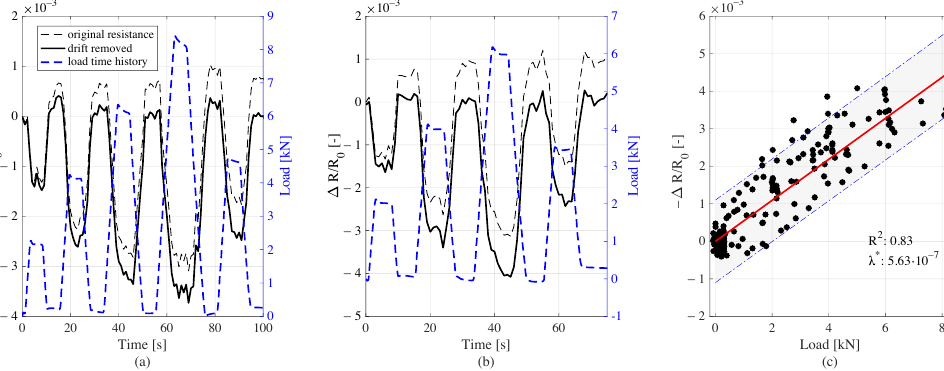
Figure 11. The results of the tests on plate; ( a ) first load cycle and the obtained resistance time history— original and drift removed; ( b ) second load cycle and the obtained resistance time history—original and drift removed; ( c ) established linear model of load